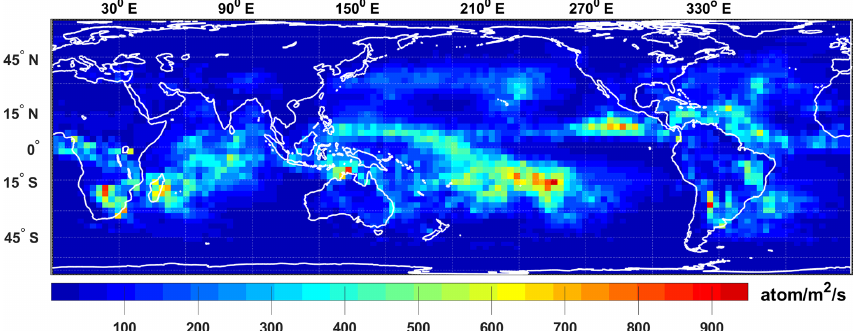
Figure 6. Lambert equal-area cylindrical projection map of 7 Be total (wet and dry) deposition averaged over the period of 2002–2008.